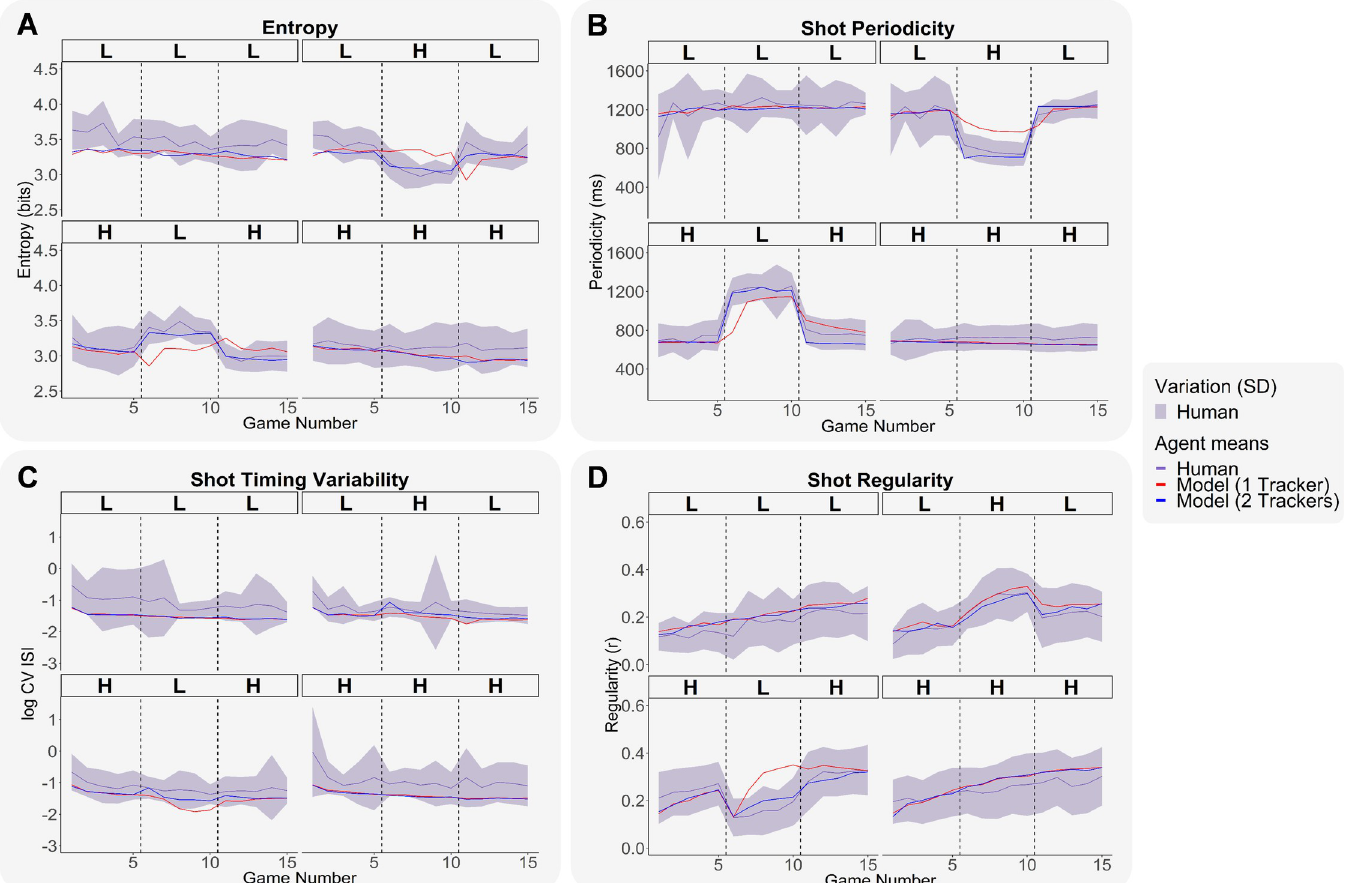
Fig 5. Human and ACT-R model motor learning measures with one vs. two trackers across the four conditions. (A) Entropy over the 15 games. (B) Shot periodicity over the 15 games. (C) Shot timing variability over the 15 games. (D) Shot regularity levels over the 15 games. Human means are shown with purple continuous lines and human standard deviations are indicated with a light purple shaded area. ACT-R model means with one tracker are shown with red continuous lines. ACT-R model means with two trackers are shown with blue continuous lines. Dashed vertical lines indicate phase switches.